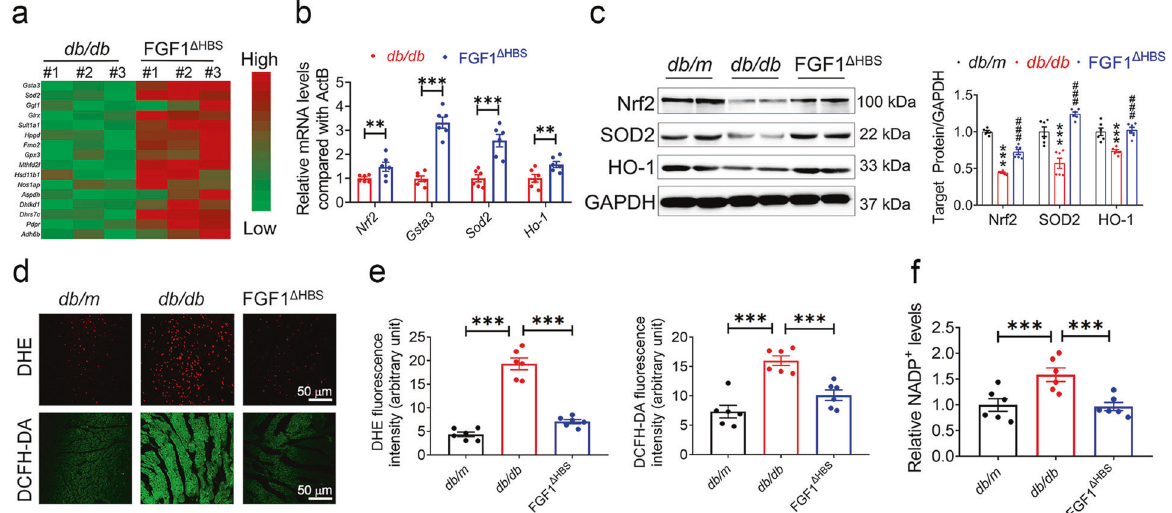
Fig. 3 FGF1 Δ HBS preserves anti-oxidant capacity in the hearts of db/db mice. a Hierarchical clustering of FGF1 Δ HBS -upregulated genes related to anti-oxidative stress based on the RNA sequencing analysis in the hearts from from db/db and db/db + FGF1 Δ HBS mice. n = 3. b The mRNA levels of Nrf2 and its target genes Gsta3 , Sod-2 and Ho-1 in the cardiac tissues. n = 6. c Western blot analysis (left panel) and densitometric quanti fi cation (right panel) of Nrf2, SOD2 and HO-1 in the cardiac tissues. GAPDH was a loading control. n = 6. d Representative images of DHE and DCFH-DA staining in the cardiac tissues. e Quanti fi cation of the corresponding fl uorescence intensity in d . n = 6. f Relative concentration of NADP + normalized to the db/m group. n = 6. Data were mean ± SEM; ** P < 0.01 *** P < 0.001 in ( b , e , f ); *** P < 0.001 vs. db/m , ### P < 0.001 vs db/db in